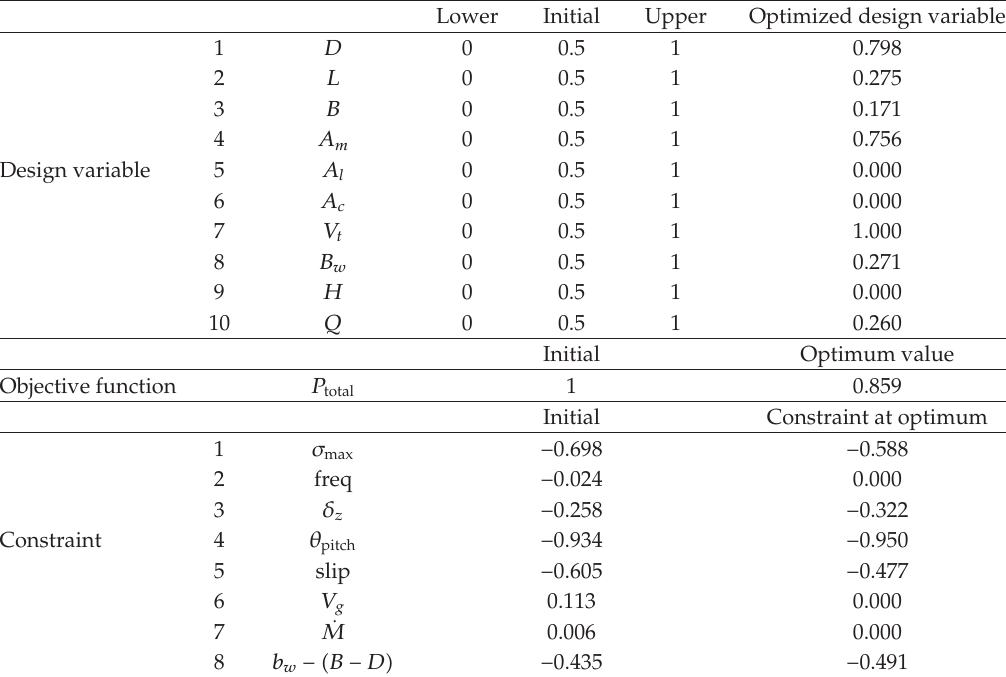
Table 2: Result of MDO for the test